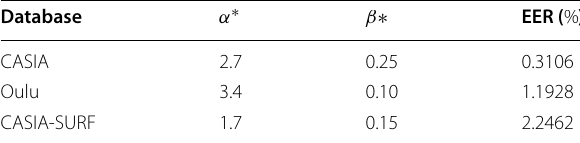
Table 7 EEE for optimal values of α ∗ and beta ∗ for